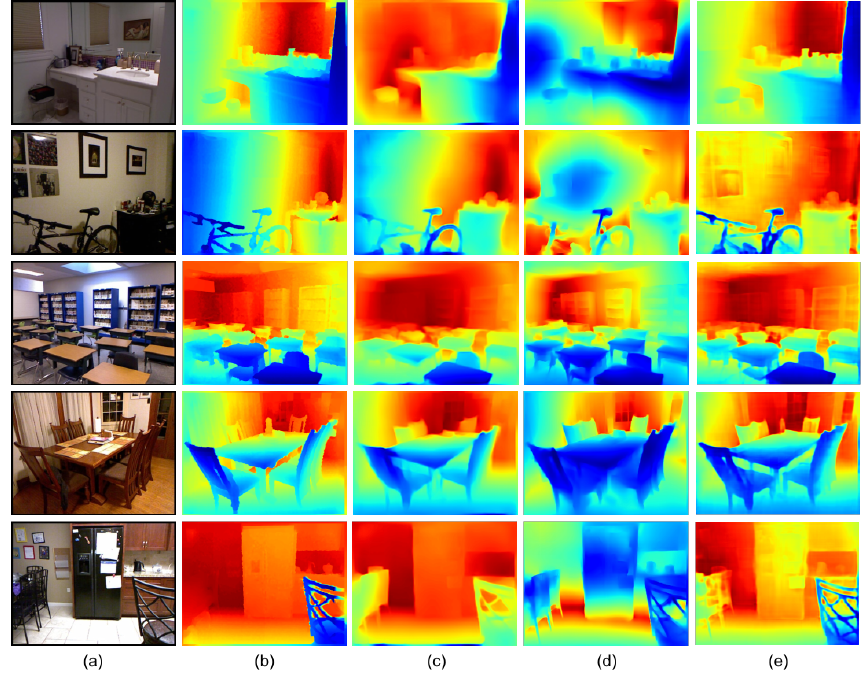
Figure 5. Qualitative examples on the NYU Depth V2 Eigen test split. ( a ) RGB image; ( b ) ground truth; ( c ) Hu et al. [64]; ( d ) Chen et al. [17]; ( e ) ours. From top to bottom, we select five RGB images